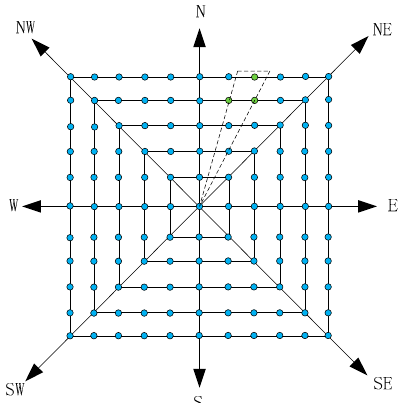
Figure 4. Viewshed computation in the reference planes algorithm. The two adjacent points between the view point (i.e., the center point of the grid) and the target point (i.e., the furthest green dot from the view point) were selected as auxiliary points. The dotted lines encloses the three types of points to form a reference plane. The relationship between the target and the plane determines whether the target point is visible.